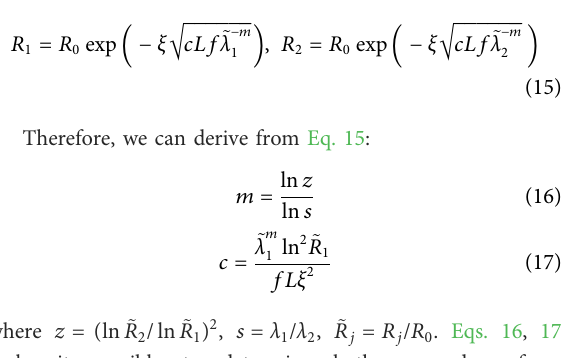
Equation 7 follows from Eq. 19 at c = 0. The plane albedo is derived using Eqs 12, 19. The values of EGD and SSA are derived as speci fi ed in Table 2. The broadband albedo (0.4 – 2.5 μ m